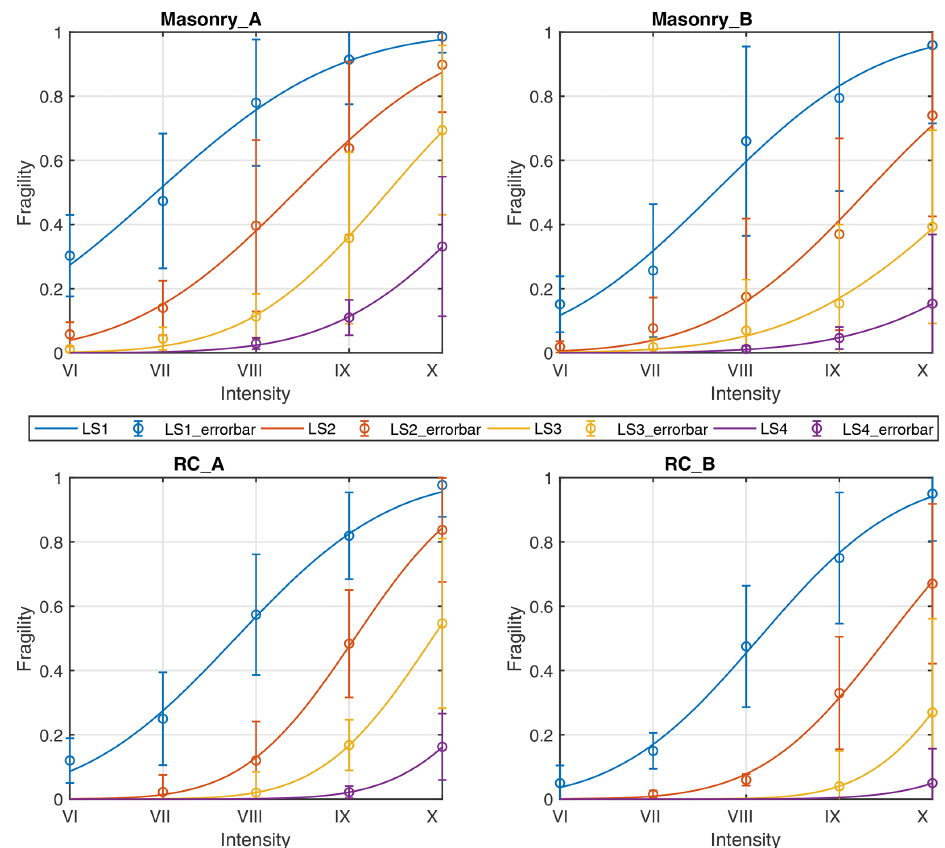
Figure 7. Median fragility curve and error-bar analysis derived from empirical fragility datasets, which depicts the relation between macro- seismic intensity and exceedance probability of each damage limit state (LS1, LS2, LS3, LS4) for masonry and RC building types (note these median fragility curves are of varying robustness; see Sects. 4 and 5.3 for more details). The circle within each bar represents the median exceedance probability of each damage limit state; the length of each bar indicates the value of the corresponding standard deviation. Only intensity and PGA values with truncated exceedance probability ≥ 1% for each damage limit state of each building type are plotted, since higher damage states can appear only for higher intensities or PGA values (see Sect. 5.2 for more details). Detailed values of median fragility and standard deviation are given in Table